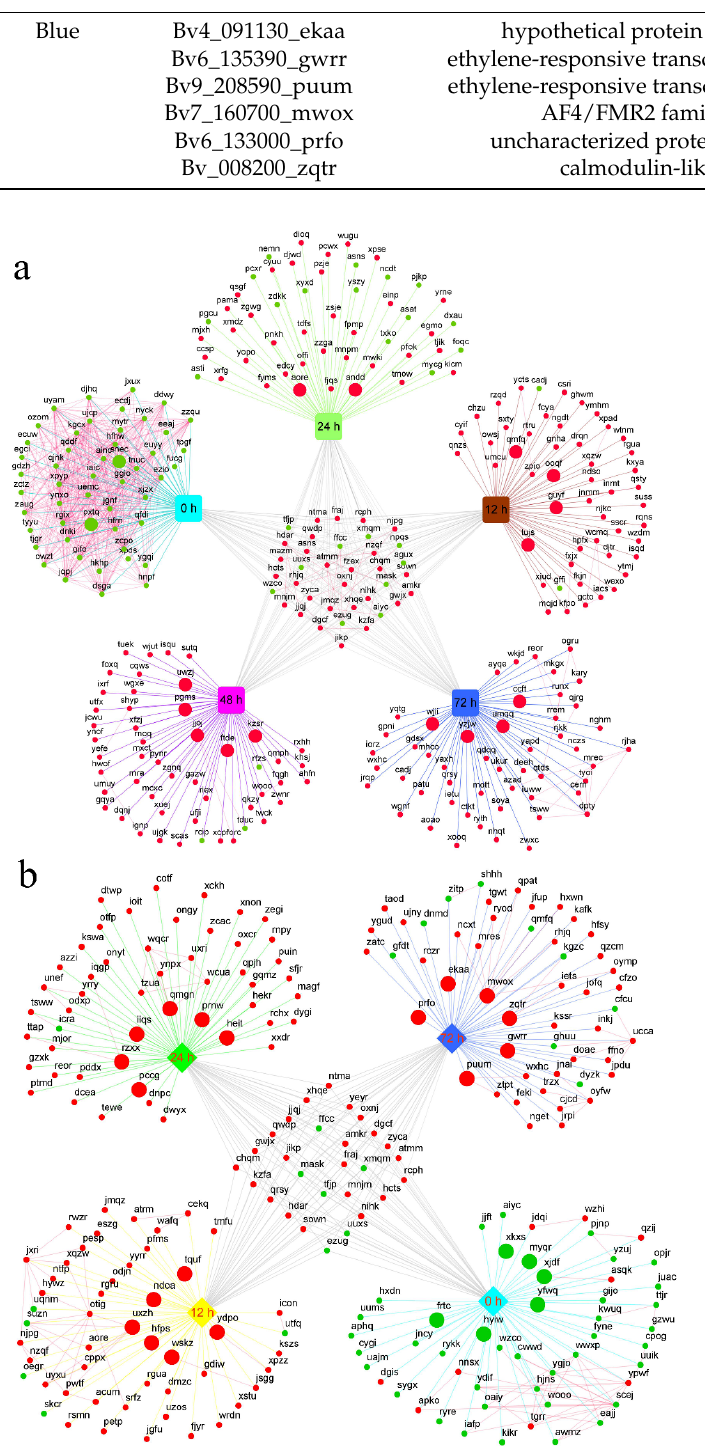
Figure 6. Transcriptional network of leaves ( a ) and roots ( b ) in responses to salt stress . The square represents the module corresponding to each color; Large dots represent hub genes, small dots represent DEGs; Red represents upregulation, green represents downregulation; The red line represents the interaction relationship annotated by the STRING database, and the other colored lines represent the affiliation relationship between genes and corresponding modules.